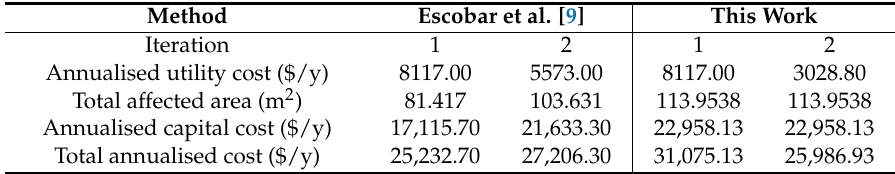
Figure 19. Overall HEN with bypass placement for Case Study 2. 103 Table 12. Comparison results of HEN total annual cost for Case Study 2. 104